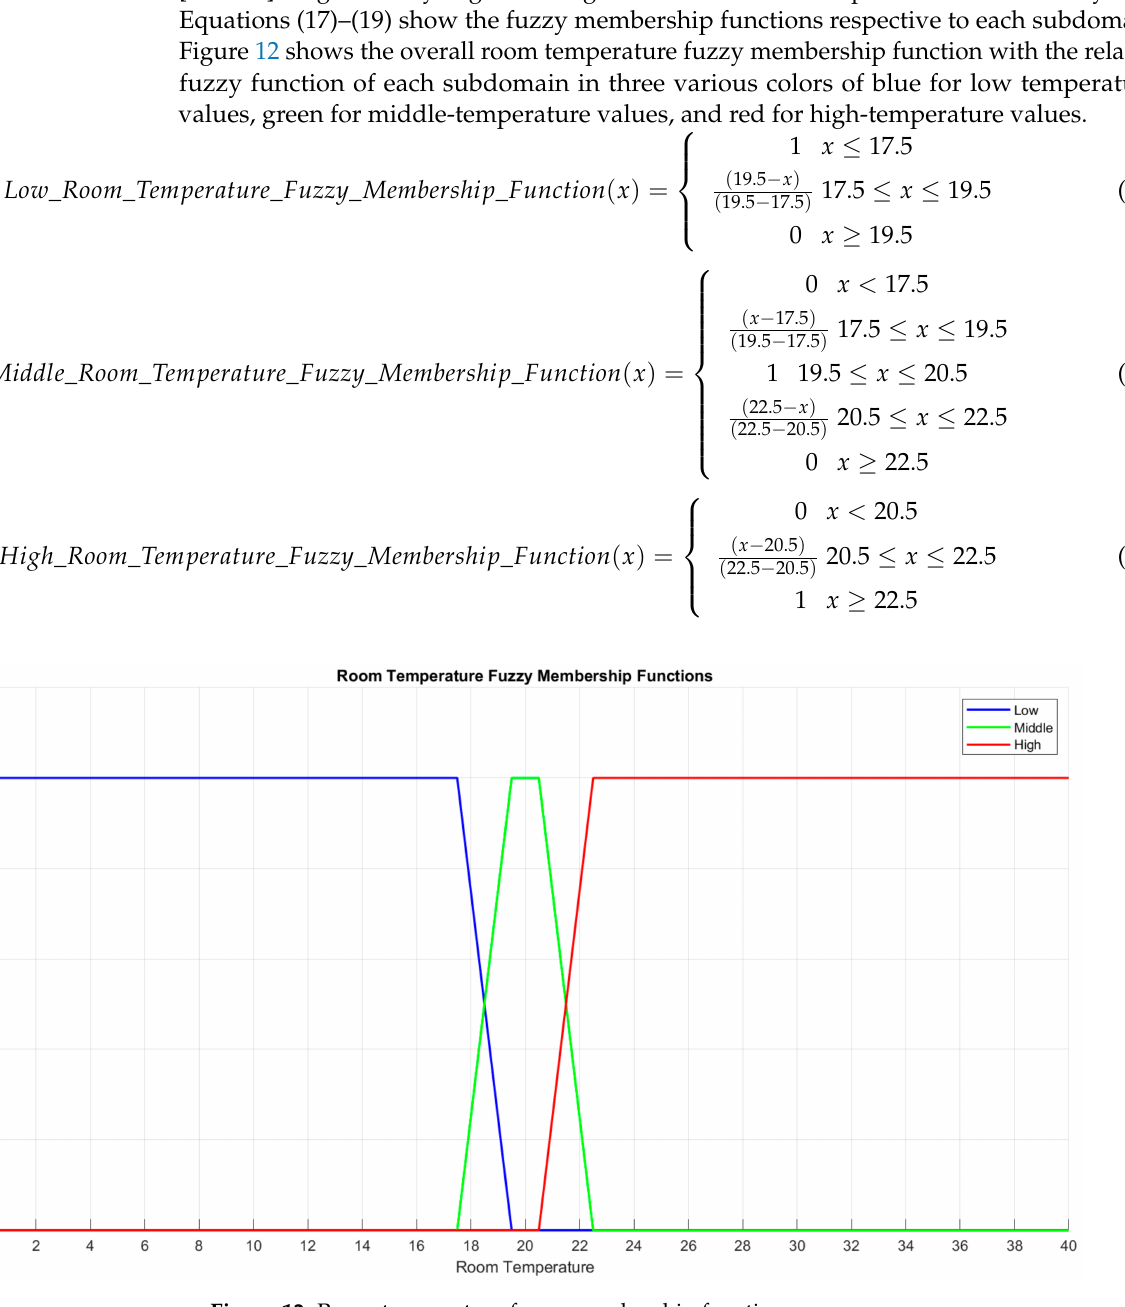
Figure 12. Room temperature fuzzy membership